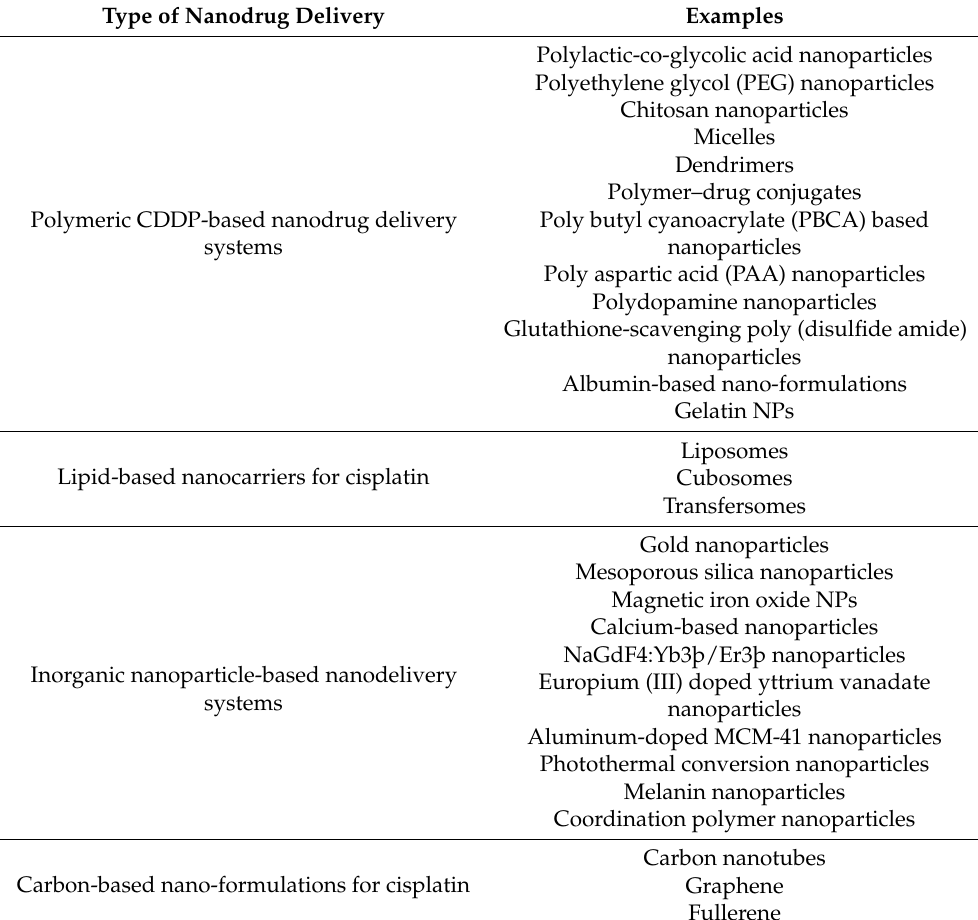
Table 2. Types and examples of cisplatin-based nanoparticle formulations for drug